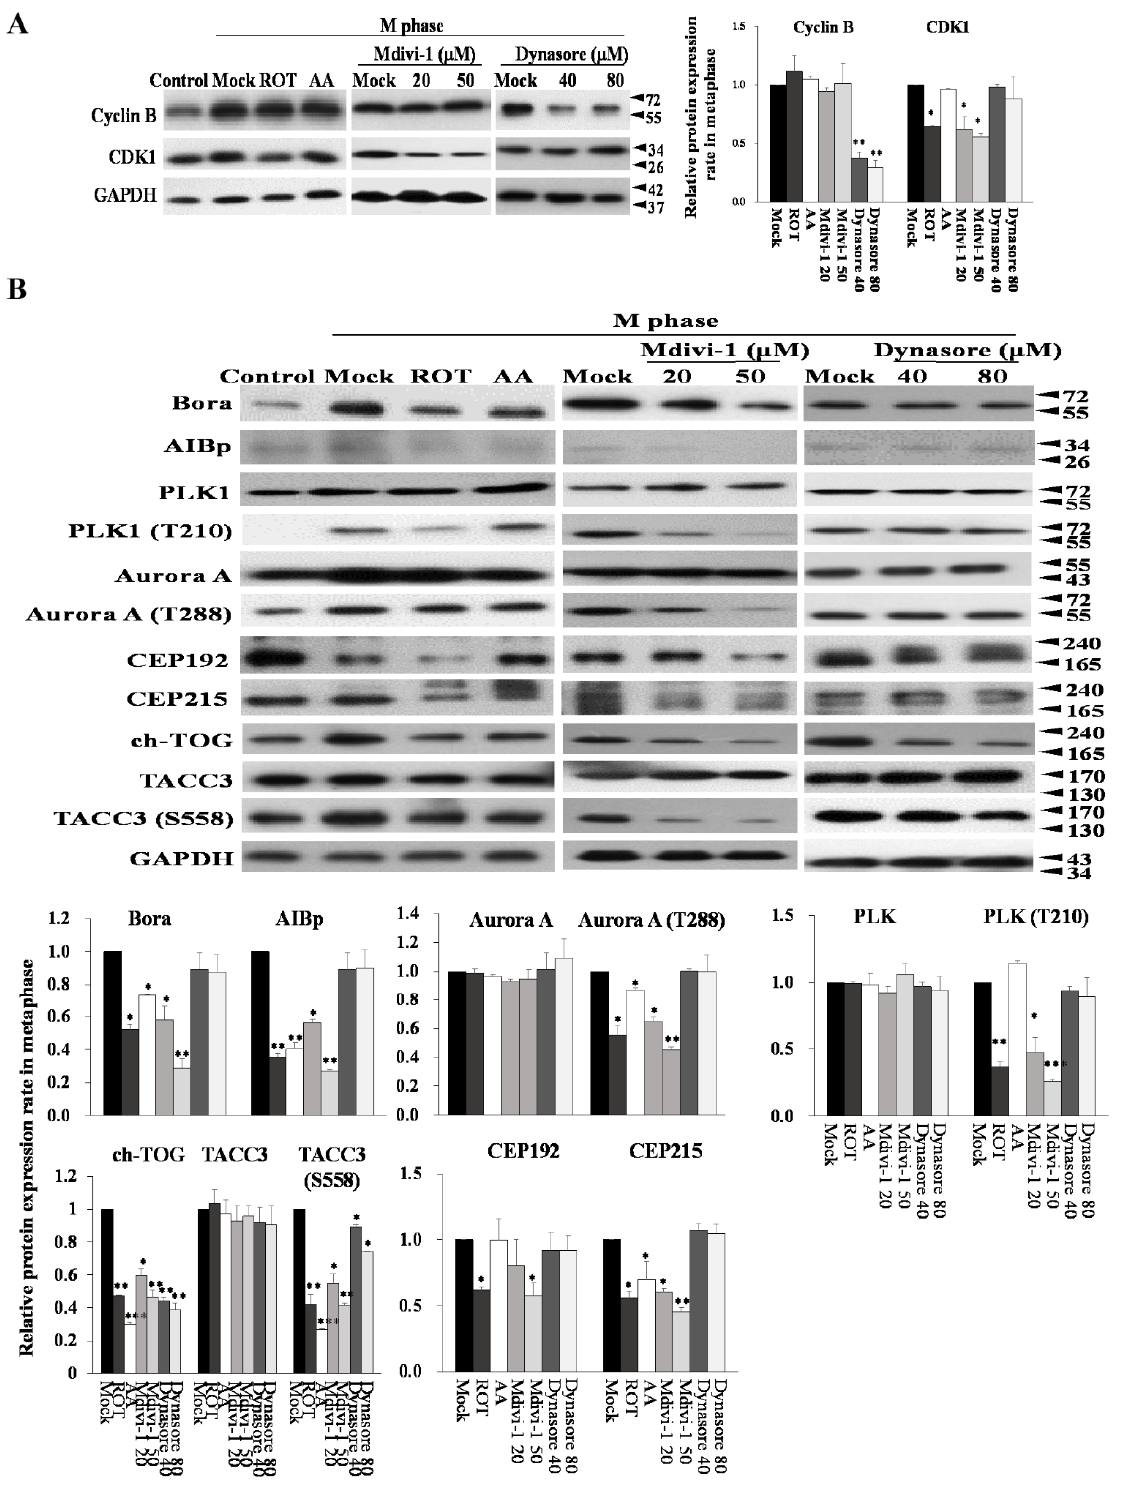
Figure 7. Blockade of mitochondrial ETC results in aberrant performance of the Aurora A/Plk1 cascade in M phase. ( A ) HeLa cells were either synchronized by a nocodazole block or were treated with ROT, AA, Mdivi-1, and Dynasore for 24 h, followed by Western blot analysis of key cell cycle regulators. ( B ) HeLa cells were synchronized in G2/M by 16 h nocodazole followed by release. Cells were treated as indicated. The Aurora A/Plk1 cascade was immunoprecipitated and samples were probed with the indicated antibodies. GAPDH was used as an internal control. The bar graph represents the mean of triplicates ± SD. * p < 0.05, ** p < 0.01, *** p < 0.001 compared with the control group. Note that all Mock lanes also as normalized M phase.